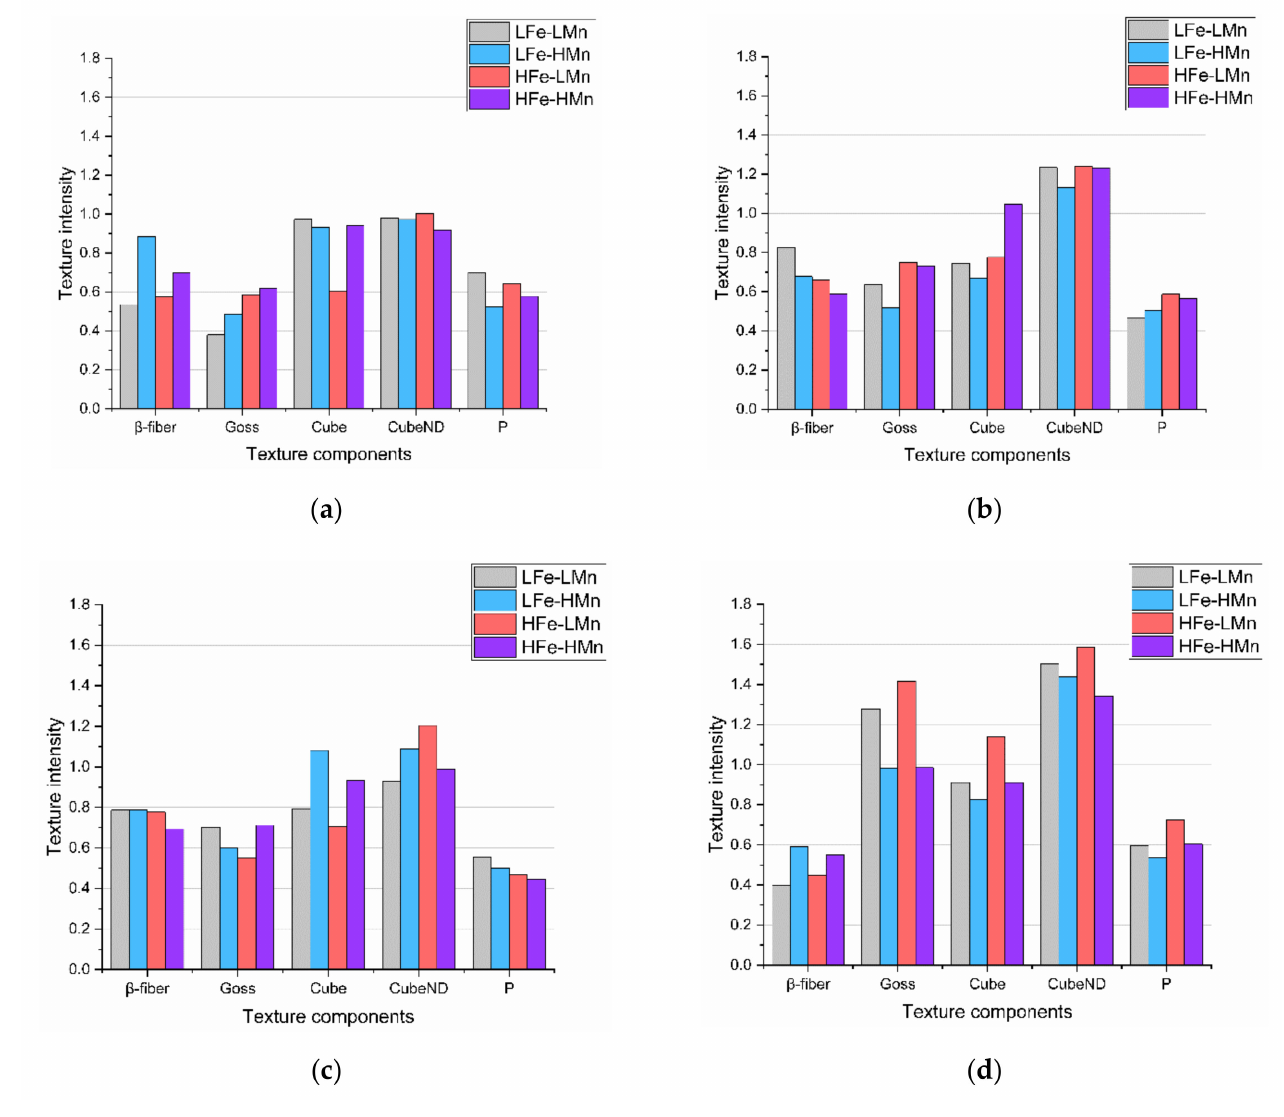
Figure 9. Influence of the processing parameters on the resulting texture of the different alloys in the final soft annealed sheets. ( a ) S-C cast, 500 ◦ C homogenized and 35% CRD. ( b ) NR-C cast, 500 ◦ C homogenized and 35% CRD. ( c ) NR-C cast, 550 ◦ C homogenized and 35% CRD. ( d ) NR-C cast, 550 ◦ C homogenized and 63%